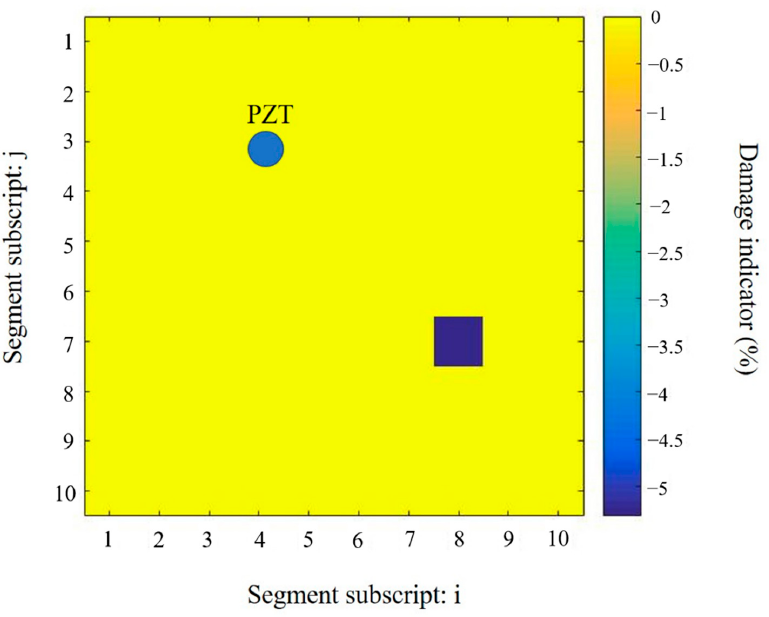
Figure 9. Location and severity of the actual damage. Table 4. Comparison of frequency shifts obtained from test results and simulations.